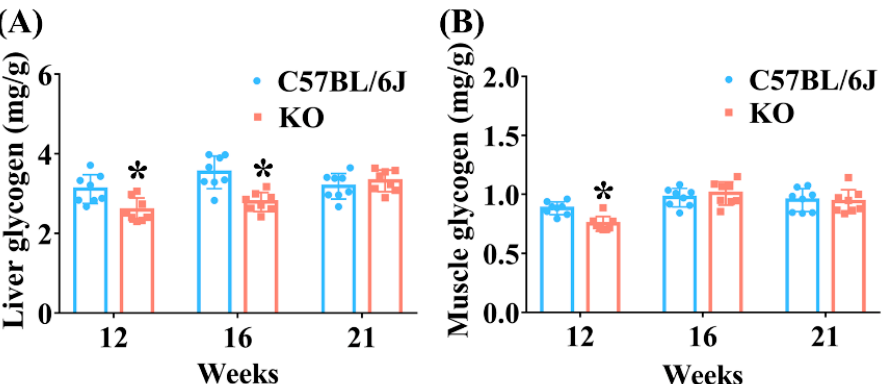
Figure 5. Glycogen contents in the liver ( A ) and muscle ( B ) of SELENOF KO and C57BL/6J mice at different ages. Data were expressed as mean ± SD ( n = 8). * p < 0.05, compared with C57BL/6J mice.